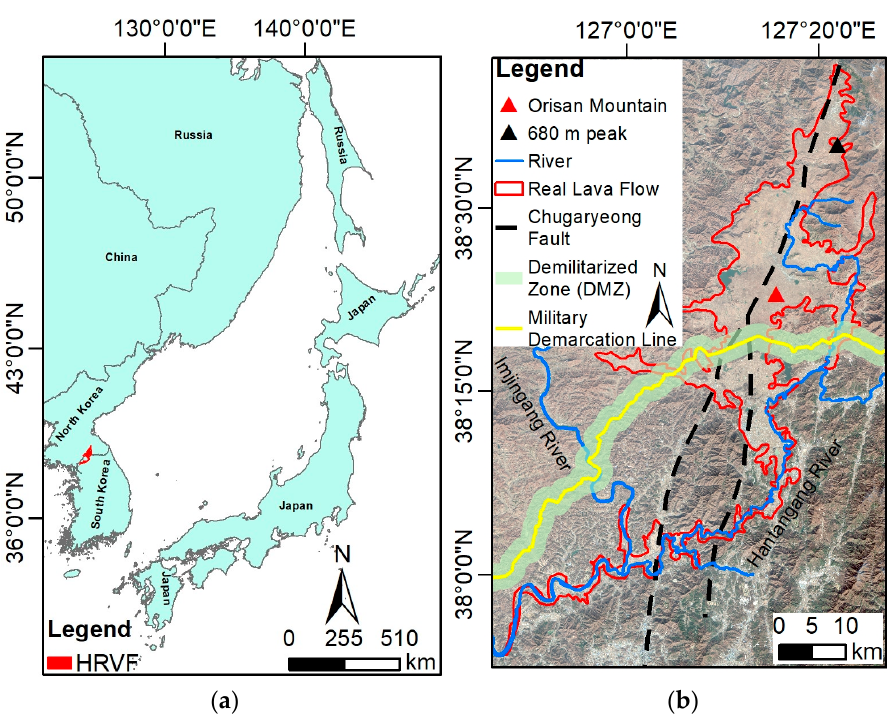
Figure 1. Location of the Hantangang River Volcanic Field (HRVF) from ( a ) the Korean Peninsula, with the segmented HRVF area modified from [14]; ( b ) digital terrain model of the study area depicted from the RGB composite of Sentinel-2 satellite imagery taken on 28 November 2021.